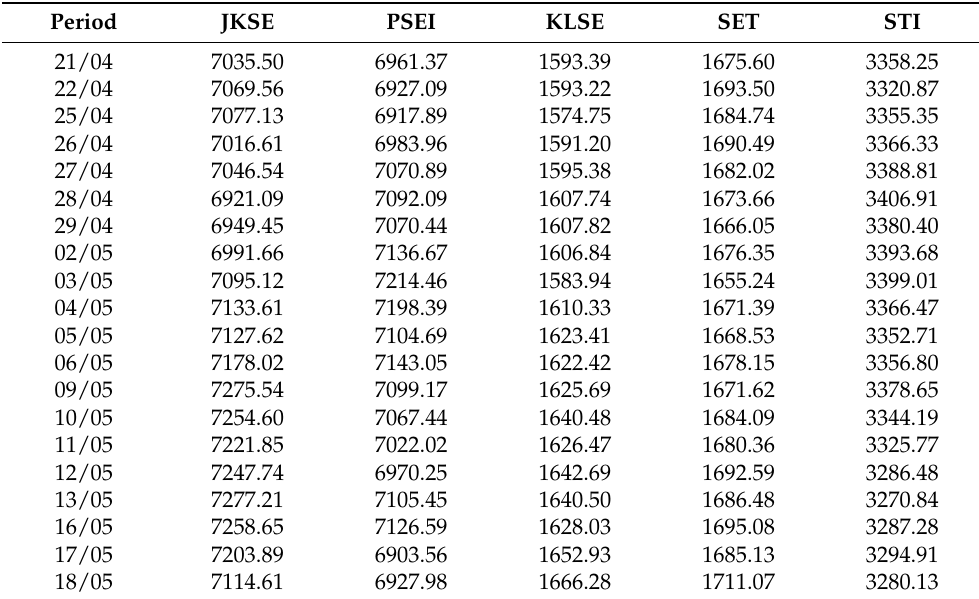
Table 9. ASEAN top 5 stock price index predictions for